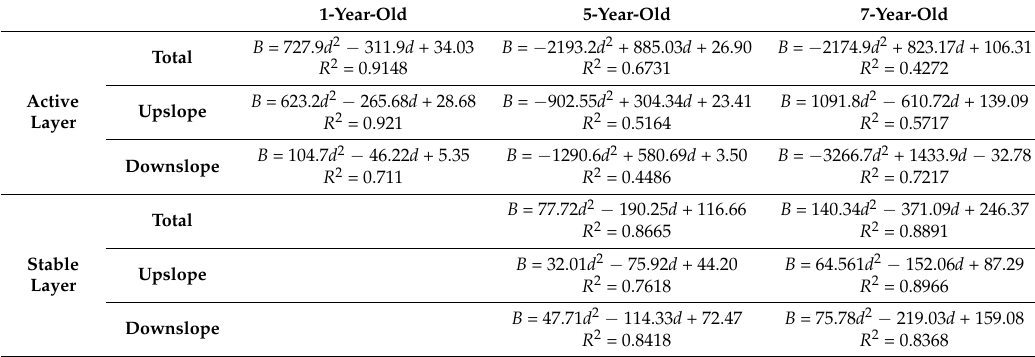
Table 4. Regression equations and R 2 values of the root material by biomass with depth in the axial direction.